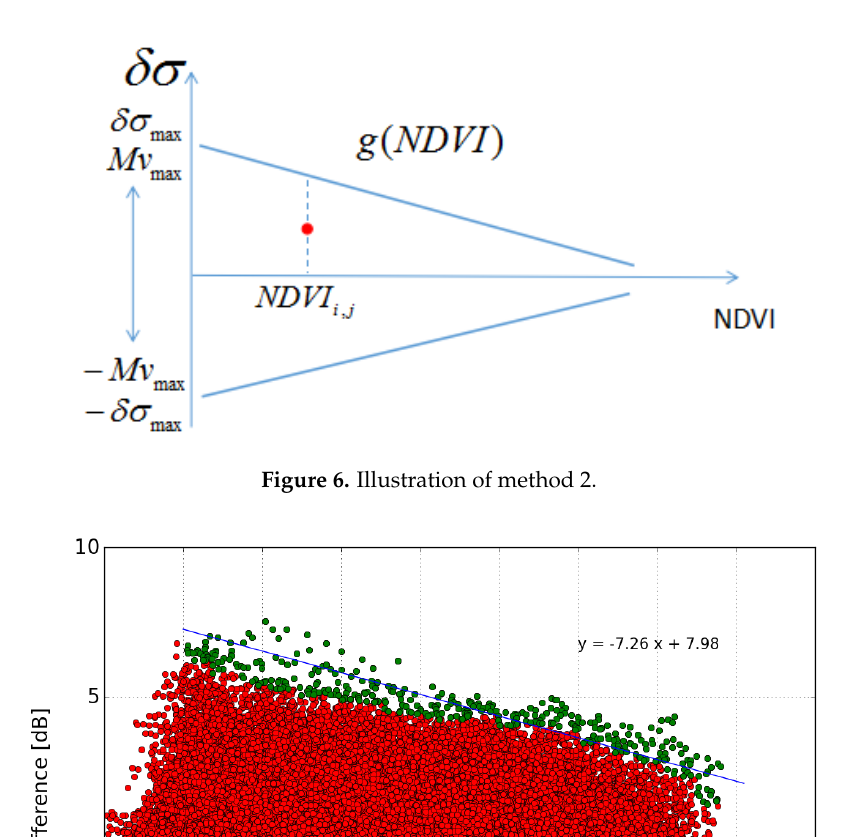
Figure 6. Illustration of method 2.